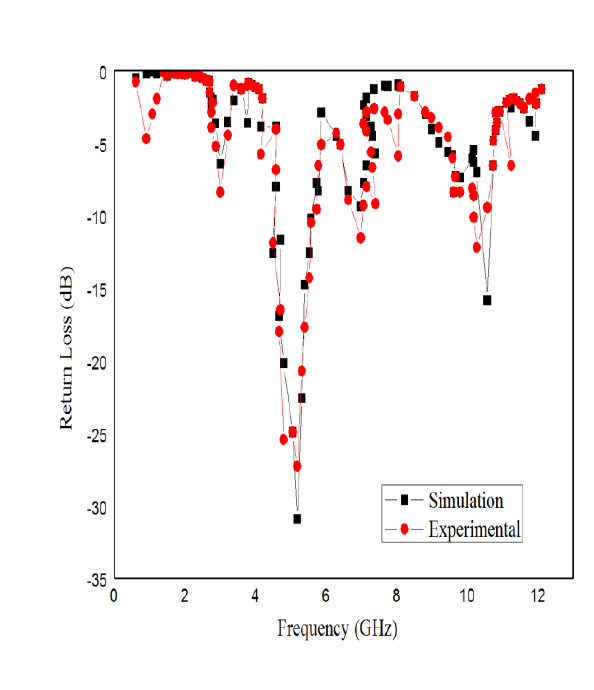
Figure 5. Simulation and Experimental variation of Return loss with frequency (with